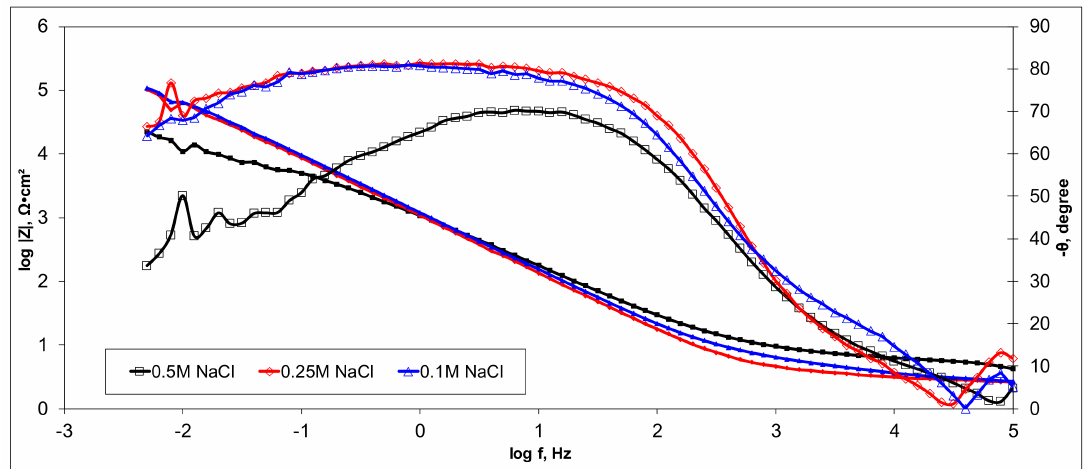
Figure 15. Bode plots for the X3 variant in NaCl: 0.5M, 0.25M,